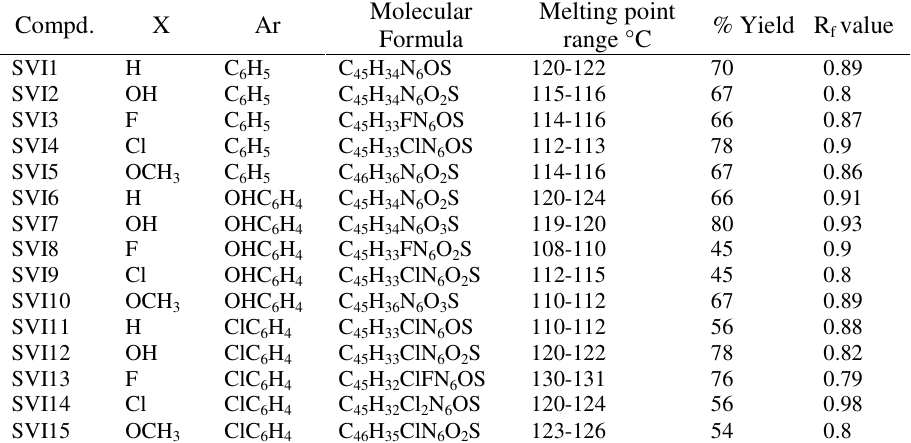
Table 1. Physical data of phenyl pyrazolo benzothiazolo quinoxaline derivatives. Compd.